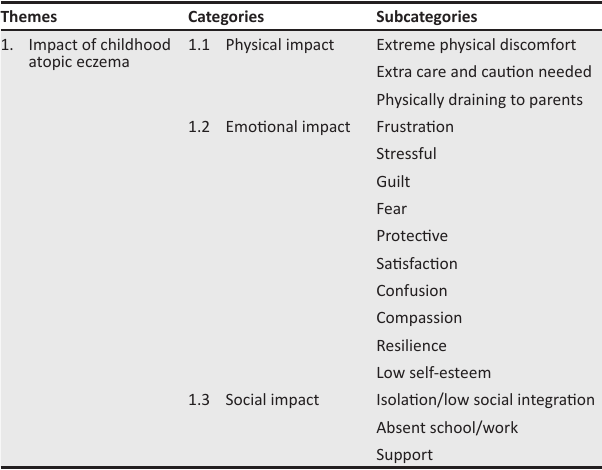
TABLE 1: Strategies to ensure trustworthiness. Strategy Application